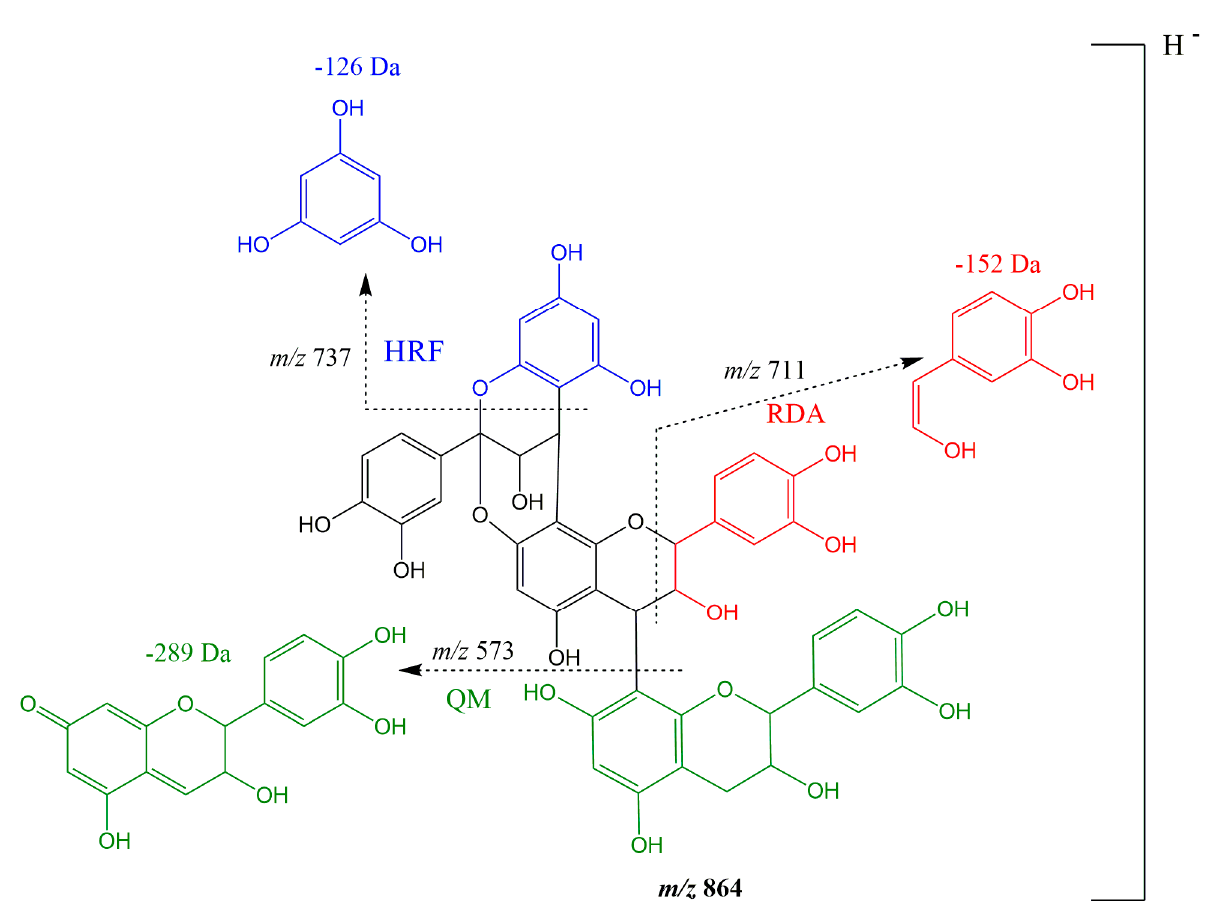
Figure 4. Fragmentation mechanisms proposed for the deprotonated molecule of A-type procyanidin trimer (ATT) by ESI(-)-MS/MS. In accordance with [41,42], we propose the trimer to be of type PC ATT [(E)C → A → (E)C → B → (E)C], in which abbreviations-related identifications of molecular species are described as follow: epicatechin (E), catechin (C), heterocyclic ring fusion (HRF), retro-Diels–Alder (RDA), quinone methide (QM). A-type linkage (A), which can be (C4 → C8), (C2 → O7) or (C4 → C6), (C2 → O7), B-type linkage (B), which can be (C4 → C8) or (C4 → C6). The C4 → C6 was rarely found to occur. The abbreviation E(C) indicates that the monomeric unit is indistinguishable using mass spectrometry.